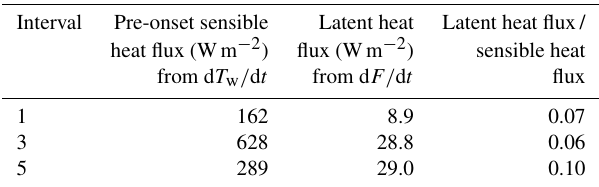
Table 2. Comparisons of pre-onset sensible heat fluxes and post- onset fluxes of latent heat from frazil